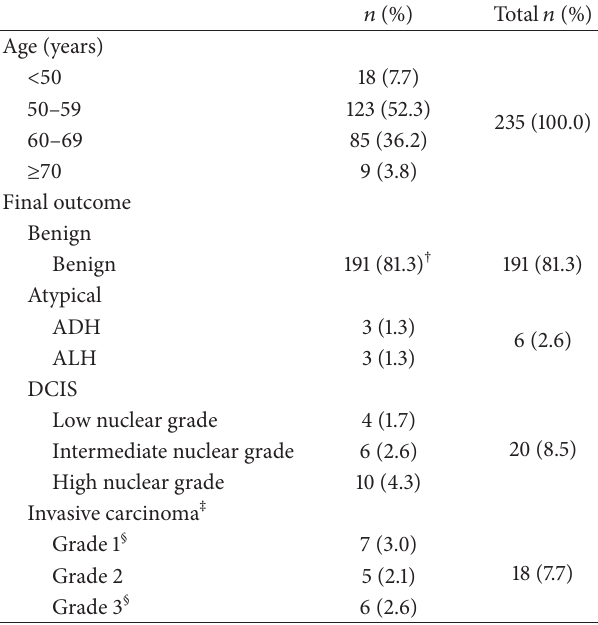
Table 1: Age distribution and final diagnostic outcome ∗ of clients with calcifications assigned a breast imaging classification 3, 4, or 5 on screening mammogram.